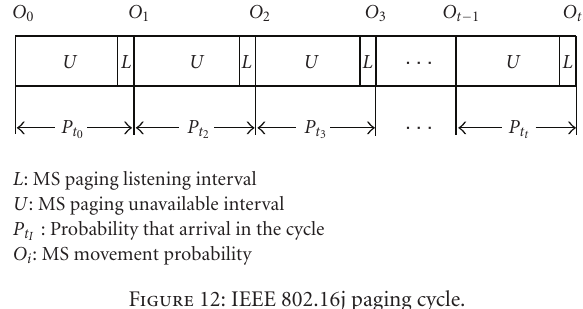
Figure 12: IEEE 802.16j paging